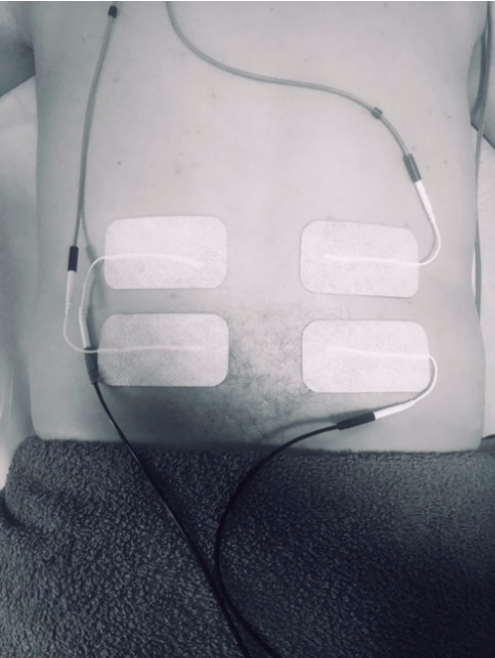
Figure 2. Position of electrodes during application of the Interferential Current technique. Subjects were asked to lay down in a prone position, with the low back area unclothed.